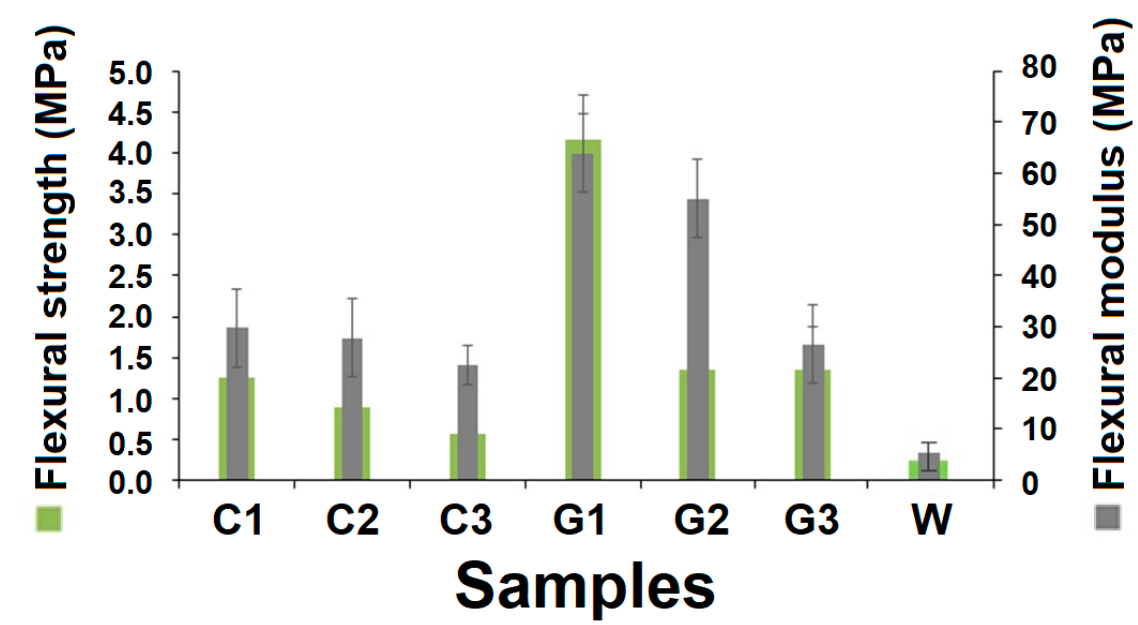
Figure 9. Flexural strength and modulus of RC and GF-reinforced hollow composites versus double-layered cardboard material.